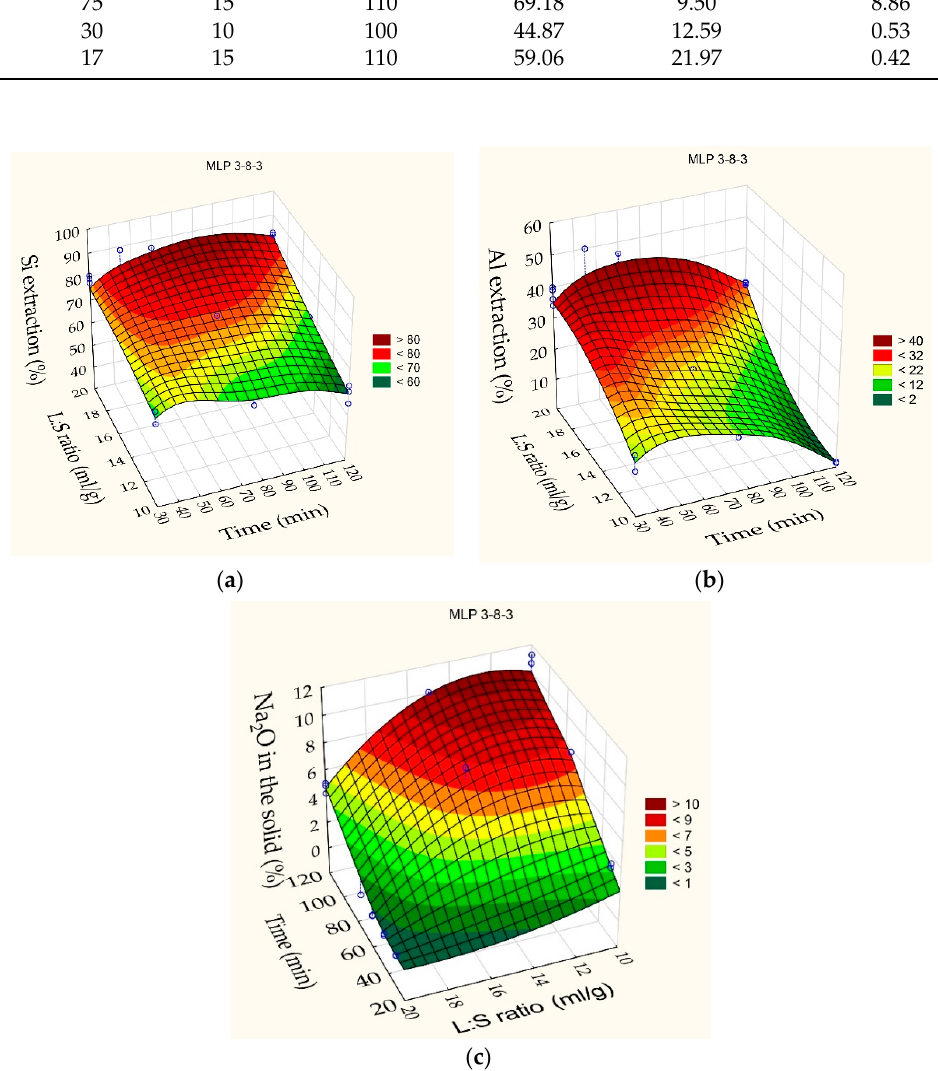
Figure 4. Neural network response surfaces for: ( a ) Si extraction degree in the alkali solution; ( b ) Al extraction in the alkali solution; ( c ) Na 2 O content in the solid residue. Blue points are the experimental data.